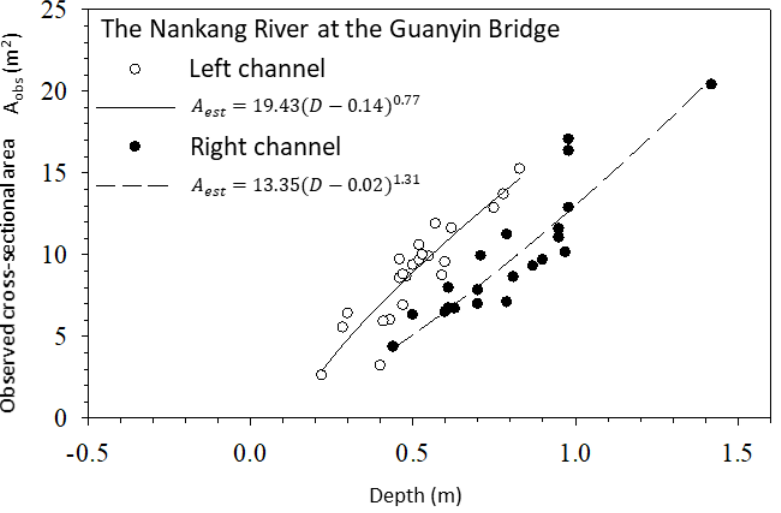
Figure 9. Relation between gage height and cross section area at the Guanyin Bridge.